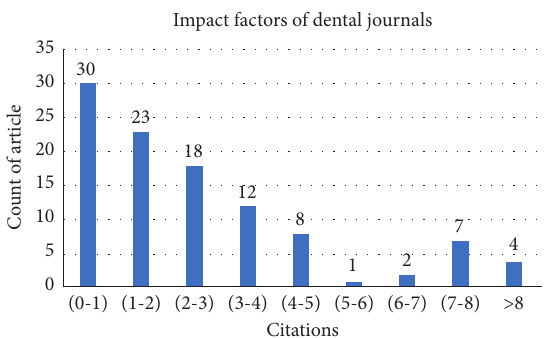
Figure 4: Graph depicting number of articles retracted from dental journals with impact factors within charted range. N � 89.